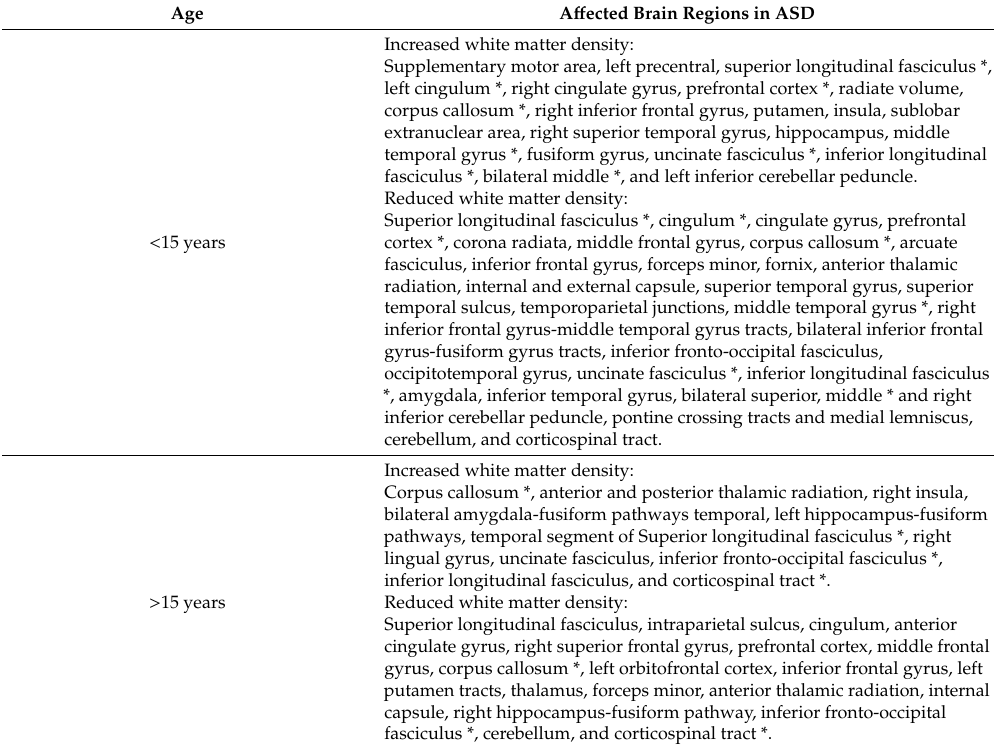
Table 1. Main changes observed in white matter regions of the ASD human brain. Age categorization was used to highlight the findings described in children and early adolescence ( < 15 years) vs. those observed in late adolescence and adults ( > 15 years). Asterisks indicate the brain regions